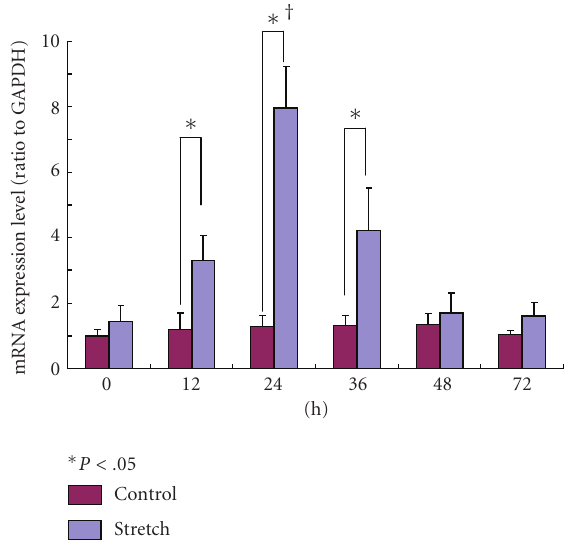
Figure 10: The expression of OPN-mRNA in the stretching group was significantly higher than the control group at 12 and 24 hours ( P < . 05). The expression of OPN-mRNA in the stretching group showed the highest value at 24 hours ( † ).